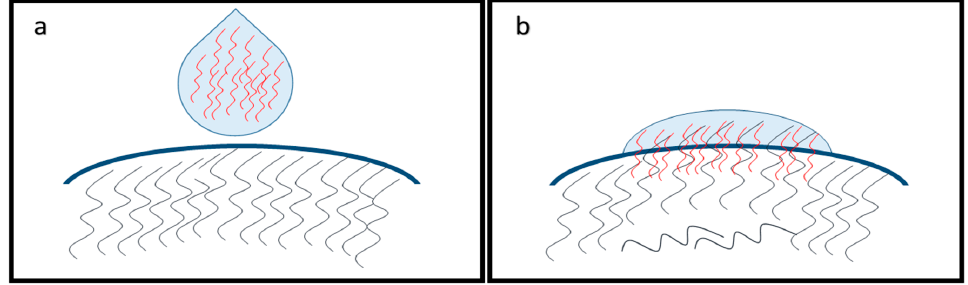
Figure 4. Mechanical theory of mucoadhesion. Before application of eye drop ( a ) and after interpenetration of polymer chains ( b ). After application, the polymer chains penetrate during the spreading of eye drop on the ocular surface.